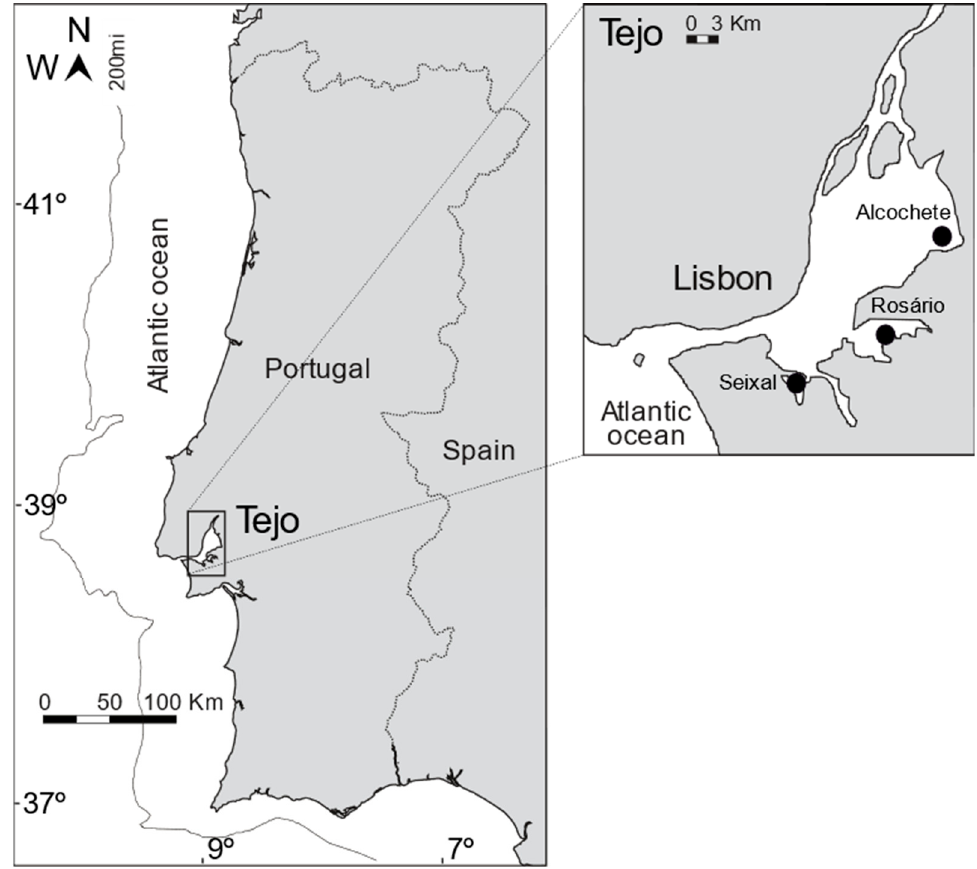
Figure 1. Overview of the sampling areas in the Tejo estuary. Black circles indicate the three sampling sites, namely Alcochete, Rosário and Seixal.